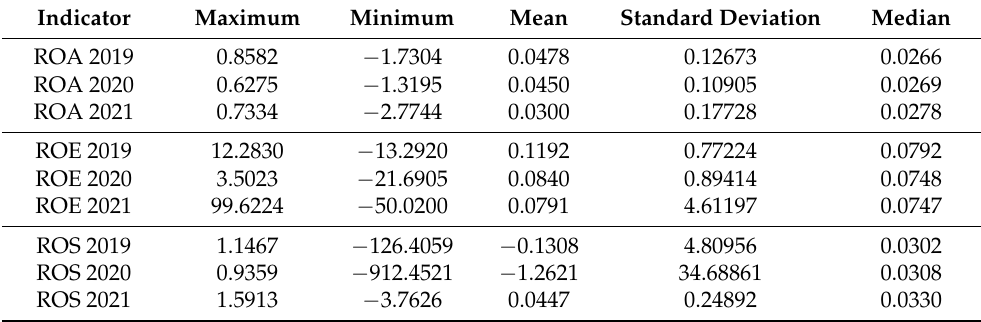
Table 2. Descriptive statistics for small companies. Source: own research.